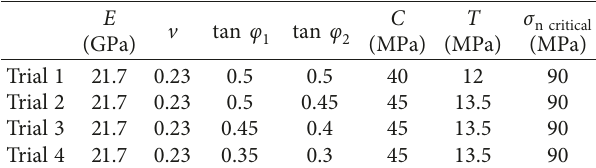
Table 2: Trial input parameters for calibration of material A.